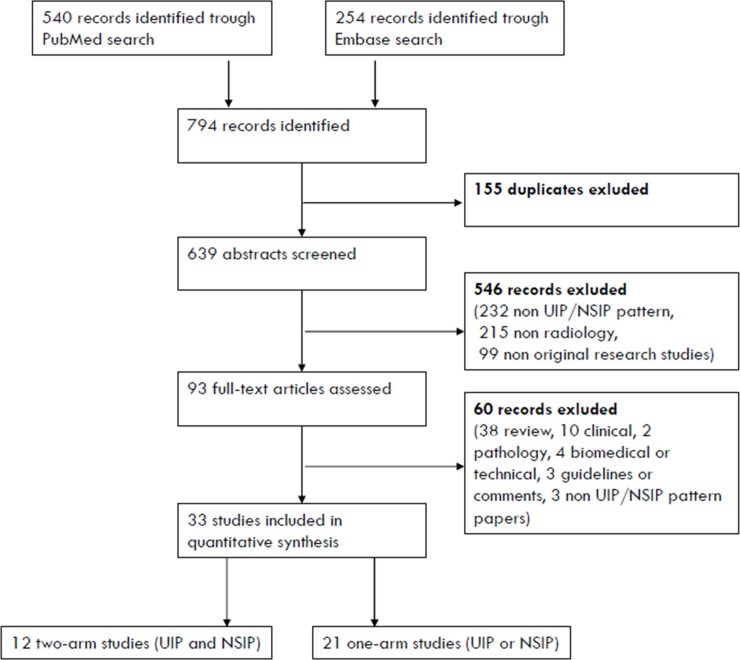
Preferred reporting items for systematic reviews and meta-analyses (PRISMA) flowchart showing the selection process.